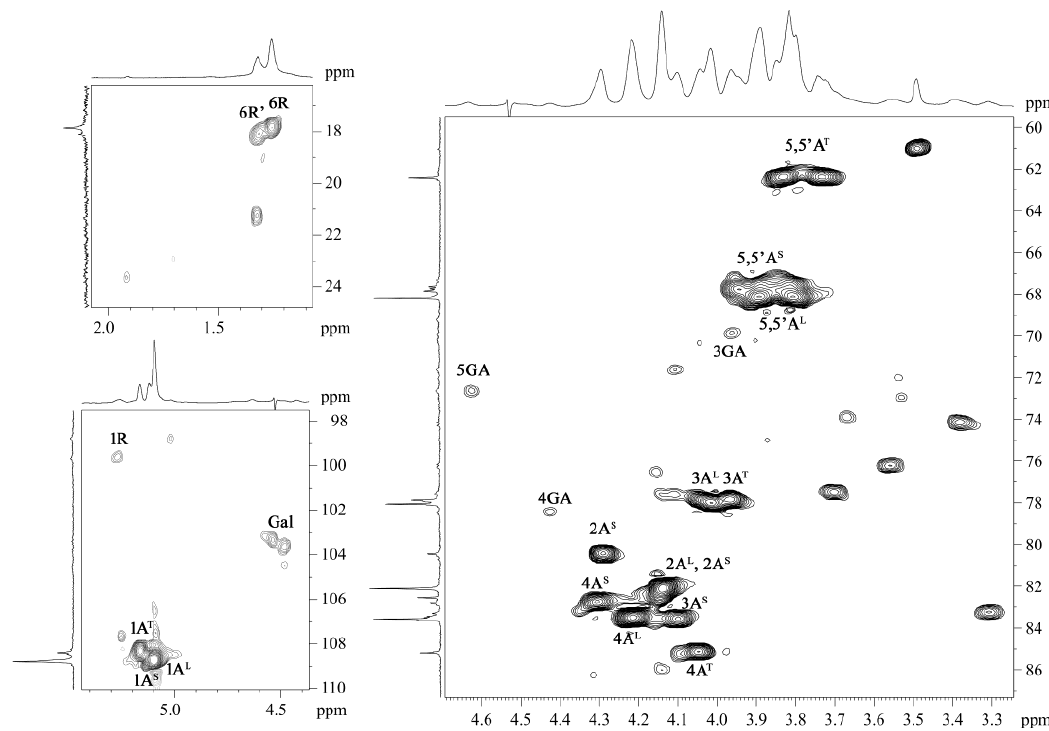
Figure 3. Parts of 1 H, 13 C HSQC spectrum of the SO1-1 . The corresponding parts of the 1 H and 13 C NMR spectra are shown along the X and Y axes, respectively. Arabic numerals refer to the carbon atoms in the residues, as designated in Table 2.